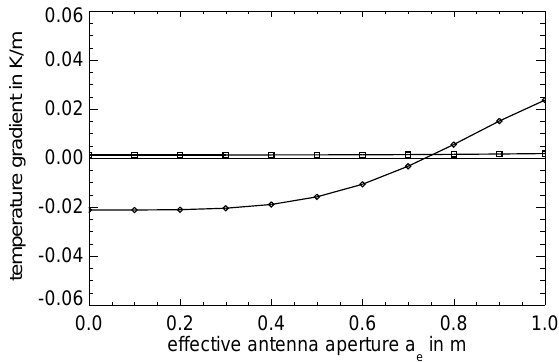
with corrections a e .Gradients